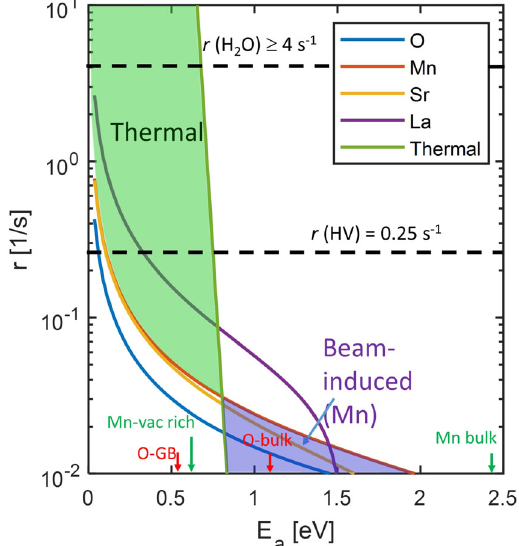
Fig. 6 Calculated beam-induced and thermally activated adatom hopping rate r at T = 22 °C as a function of the surface activation energy E a . Additionally, the experimentally observed Mn-adatom hopping rates in high vacuum r (HV) and r (H 2 O) in 0.5 Pa H 2 O are indicated. Colored areas mark the regimes for thermally and beam-induced hopping for Mn. The activation energy of O diffusion in bulk LMO is from ref. 65 and for O in Sr- doped LMO grain boundaries from ref. 66 . For the activation energy of Mn the lower and upper limit of Mn diffusion in LMO are indicated, since it shows a broad range of values, depending on the La-off-stochiometry of the sample 67 . See method section for details of the calculations.